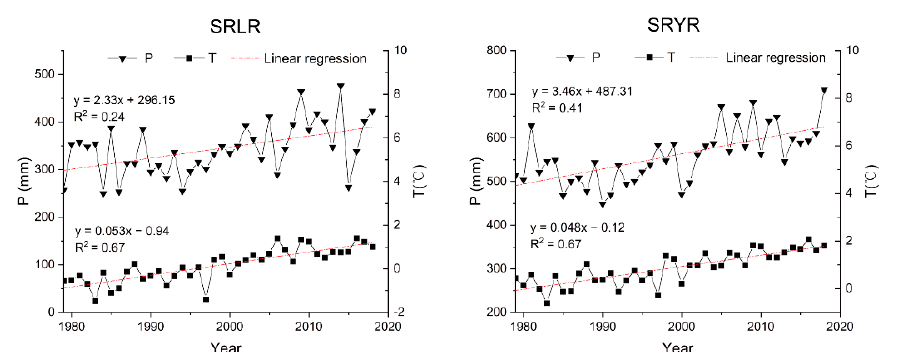
Figure 2. Long-term variations in precipitation and temperature (T) in SRLR and SRYR.